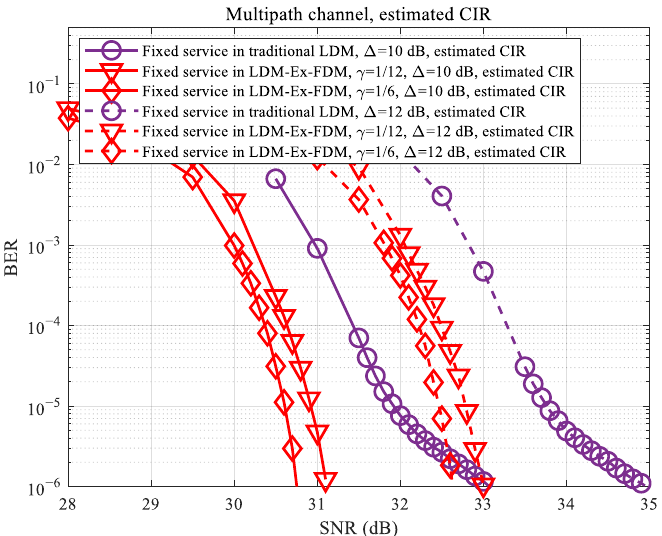
Figure 17. BER performance of fixed service in ATSC 3.0 system with and without LDM-Ex-FDM scheme with estimated channel impulse response (CIR) under the multipath channel, where the parameters of the ATSC 3.0 system were set to ∆ = 10 and 12 dB, the CL constellation was set to QPSK, the EL constellation was set to NU − 64QAM, and the puncturing rate of the LDM-Ex-FDM scheme were set to 1/6 and 1/12.